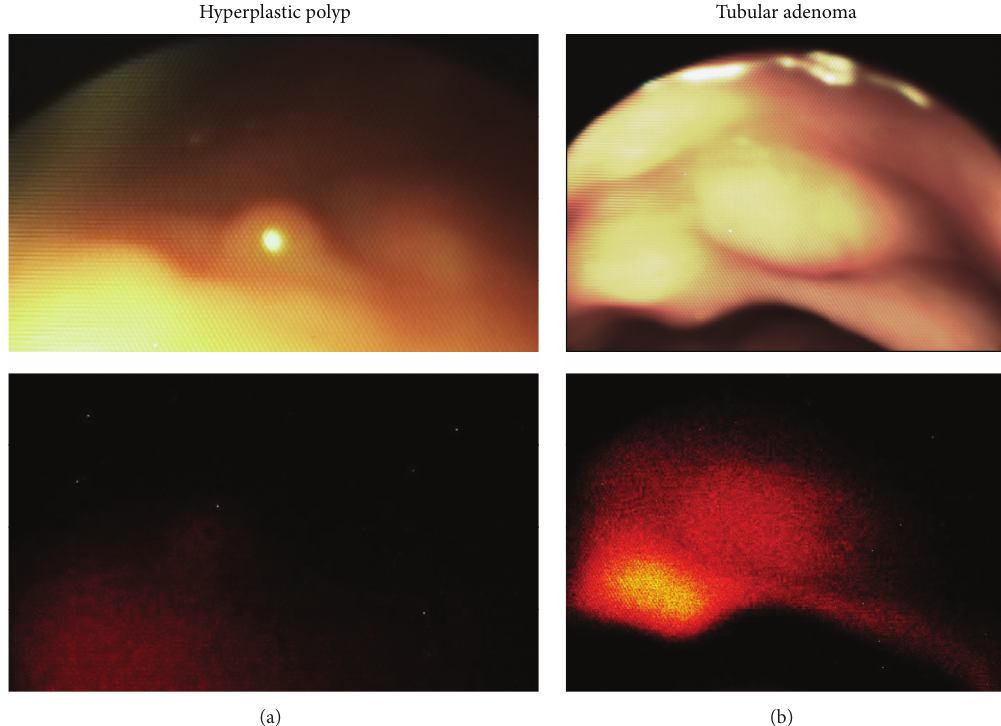
Figure 2: Patient 1 fluorescence endoscopy. A benign polyp (hyperplastic, left) demonstrates no substantial ICG uptake over background (TBR 1.0), while a neoplastic one (tubular adenoma, right) does (TBR 1.7).